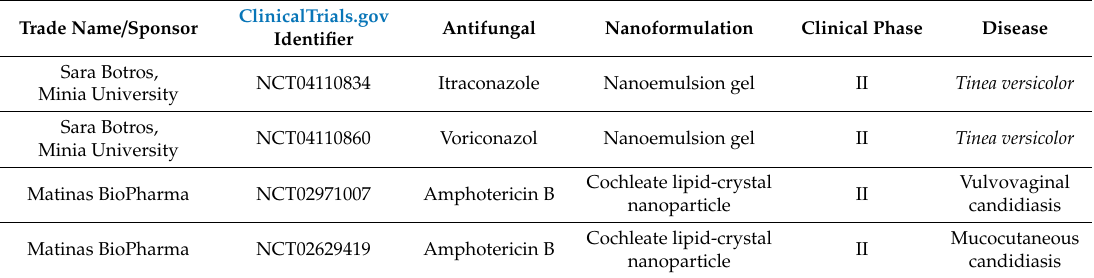
Table 5. Some examples of ongoing clinical trials on myconanotechnology